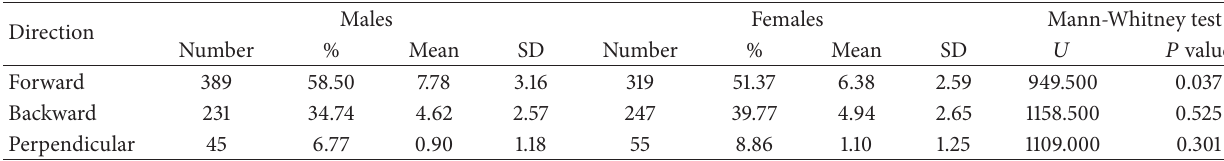
Table 3: Descriptive statistics for palatal rugae directions in both sexes.